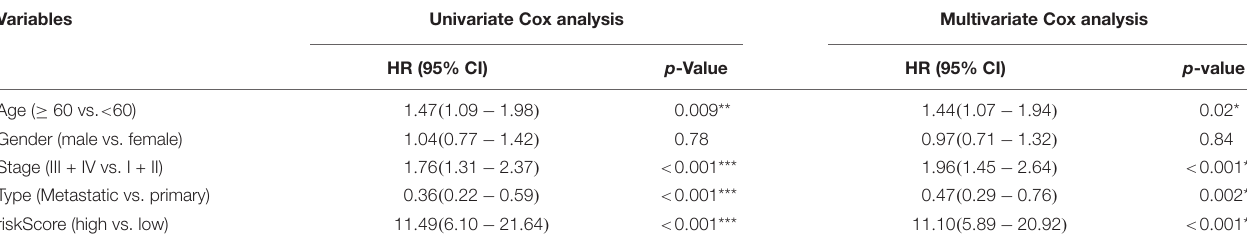
FIGURE 7 | Correlation analysis of risk score and clinicopathological characteristics of SKCM patients in TCGA. (A–C) Correlation analysis between risk score and different patient types showed that risk score was related to TME cluster grouping ( p < 0.001) (A) and tumor type ( p < 0.001) (B) . There was no significant correlation with the patient’s tumor mutation burden (TMB) ( p = 0.6). (D–I) The correlation analysis between the risk score and different clinicopathological characteristics of SKCM patients showed that the risk score and gender ( p = 0.01) (D) , stage ( p = 0.0027) (E) , and T stage ( p < 0.001) (F) are related, but there is no significant correlation between the patient’s age (G) , M stage (H) , and N stage (I) . TABLE 2 | Univariate and multivariate Cox analyses of patients’ OS prediction based on risk score in TCGA database. Variables Univariate Cox analysis Multivariate Cox